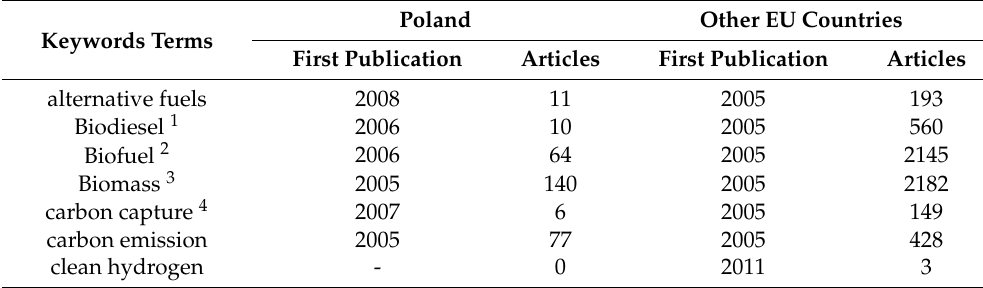
Table 9. The Green Deal keywords regarding innovative technologies and infrastructure (numerical values on the basis of Scopus database,